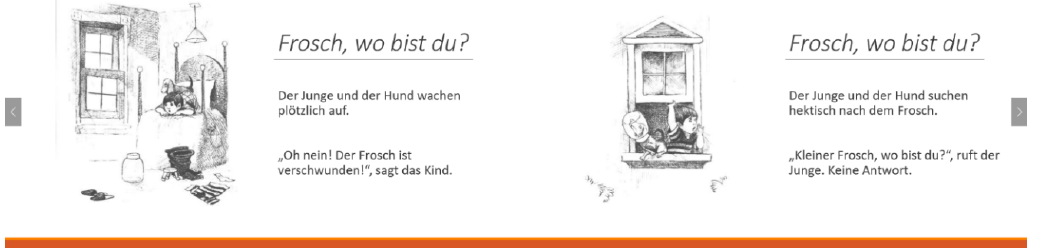
Figure A3. Pretest: Production task.